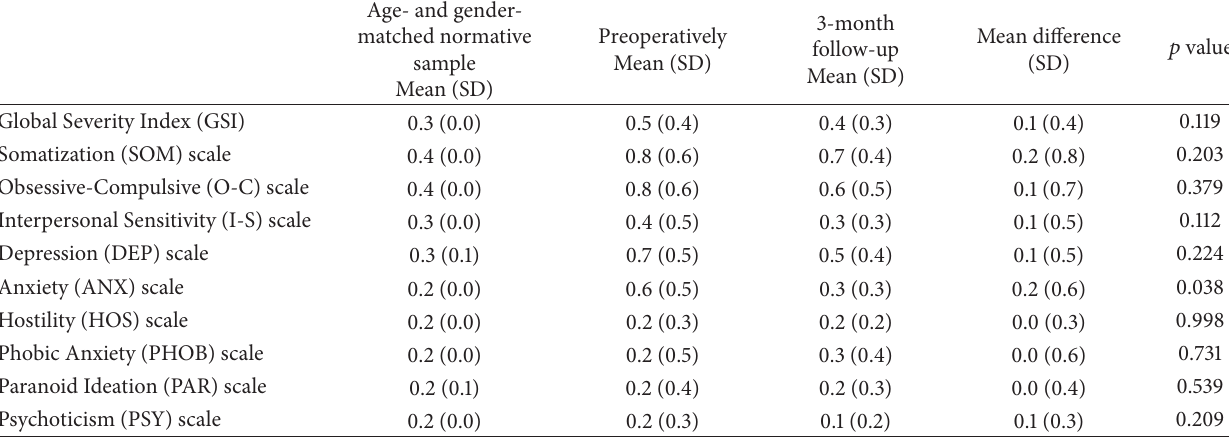
Table 4: Comparison of the SCL-90-R Global Severity Index (GSI) and the nine symptom dimensions between age- and gender-matched Norwegian normative population and patients’ scores preoperatively and after three months of STN-DBS. Data are presented as mean-scores and standard deviations (SD) along with mean differences between patients’ scores preoperatively and at three months follow-up and 𝑝